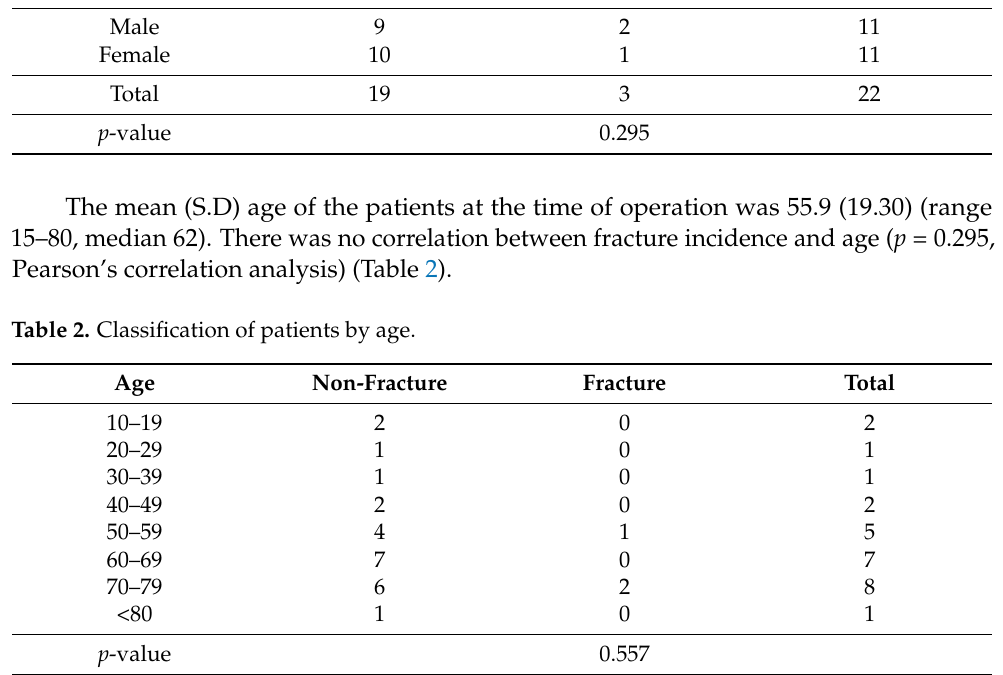
Table 1. Classification of patients by sex.